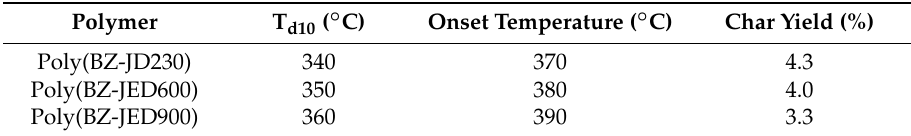
Table 2. Thermal degradation of PEG-based polybenzoxazine